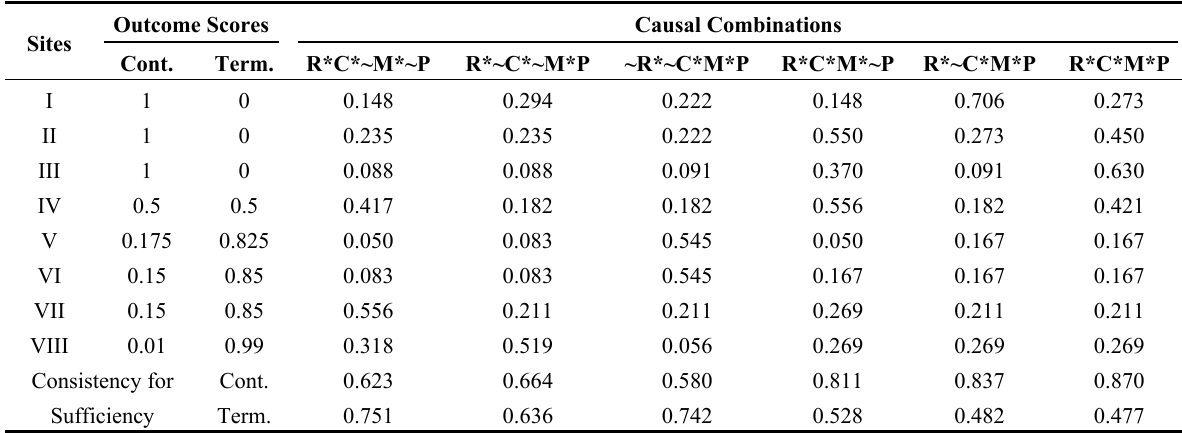
Table 2. Membership scores of all sites (roman numerals) in the causal combinations with at least one case with a membership score above